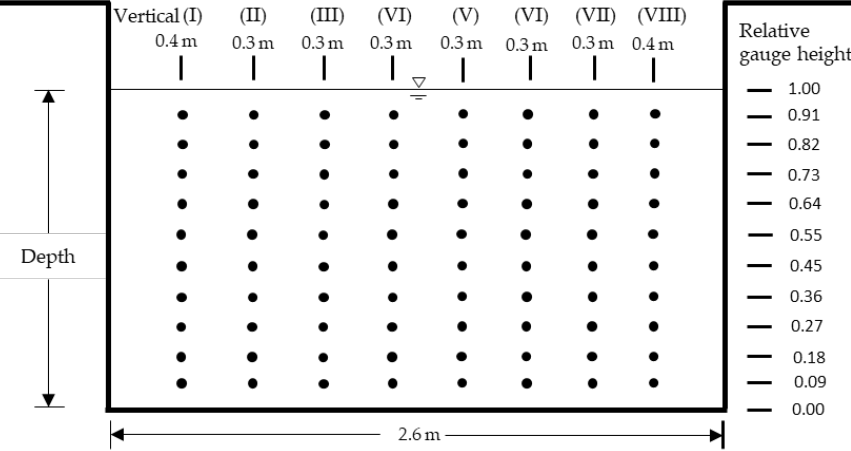
Figure 6. Discharge measurement at the Longen Channel.